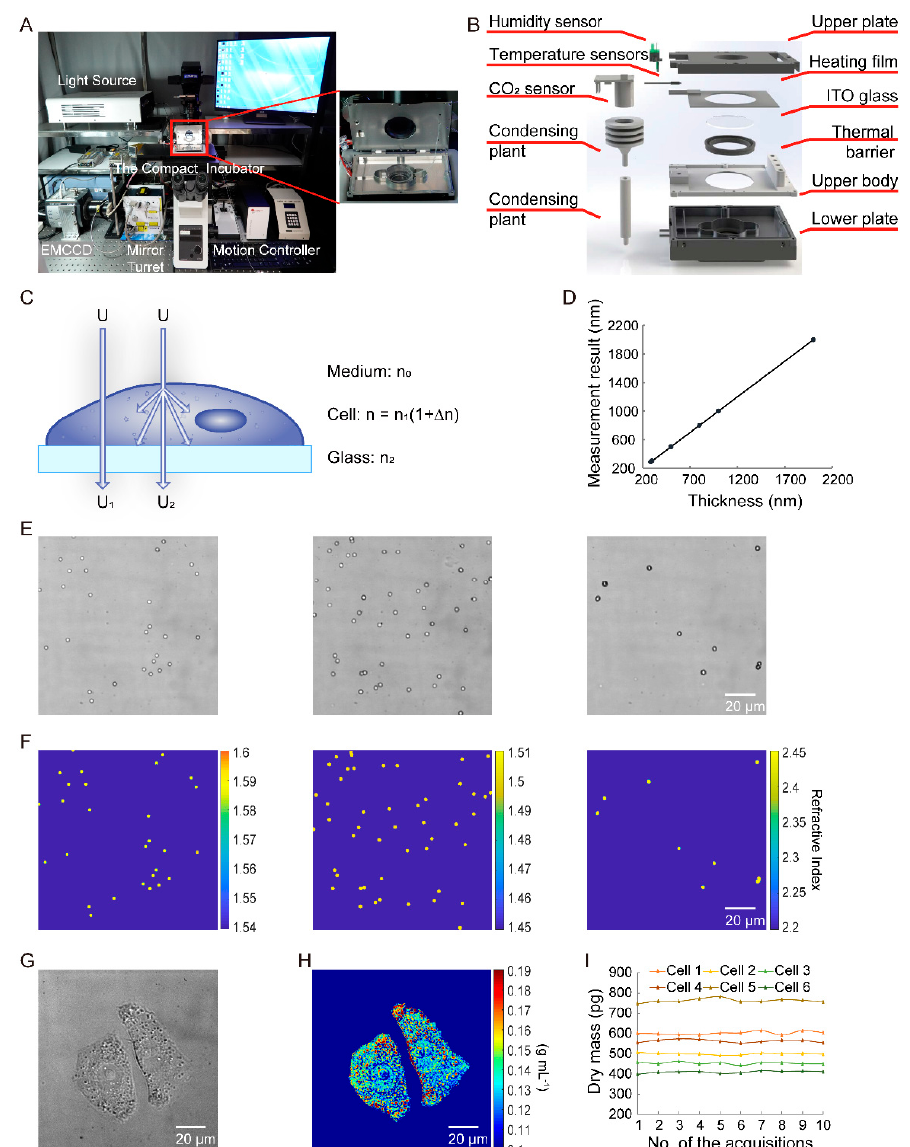
Figure 1. The theoretical principle of multichannel wide-field interferometric imaging (MWII) technique. ( A ) The imaging system. ( B ) The structure of the compact incubator. ( C ) The mathematical description of the light propagation. ( D ) Wafer thickness measurement results. ( E ) Imaging results of polystyrene, polymethyl methacrylate and iron oxide microspheres with differential interference contrast (DIC) microscopy. ( F ) Reconstruction results of microspheres with MWII, in which the quantitative colors indicate the refractive index of the microspheres. ( G ) Imaging results of fixed HeLa cells with DIC microscopy. ( H ) Reconstruction results of fixed HeLa cells with MWII, in which the quantitative colors indicate the density of the cells. ( I ) The dry mass measurement results of six fixed single HeLa cells after 10 acquisitions